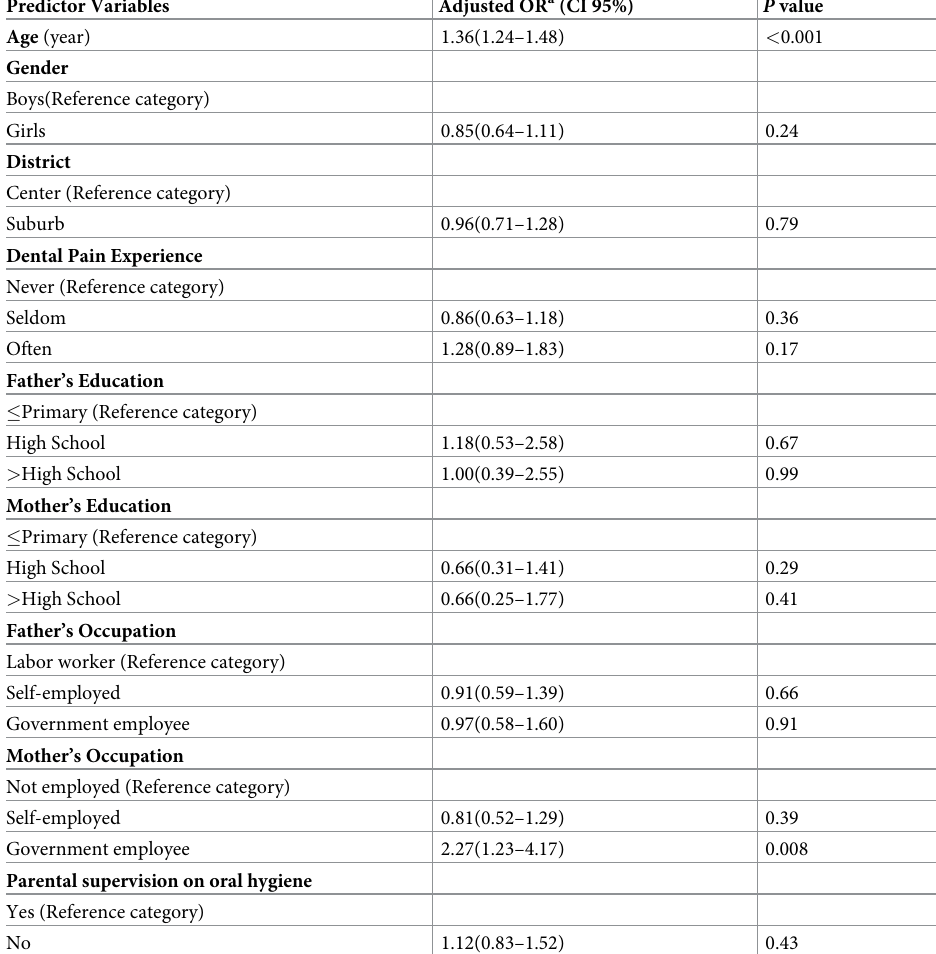
Table 3. Association between socio-demographic factors and OHI-S according to multiple logistic regression